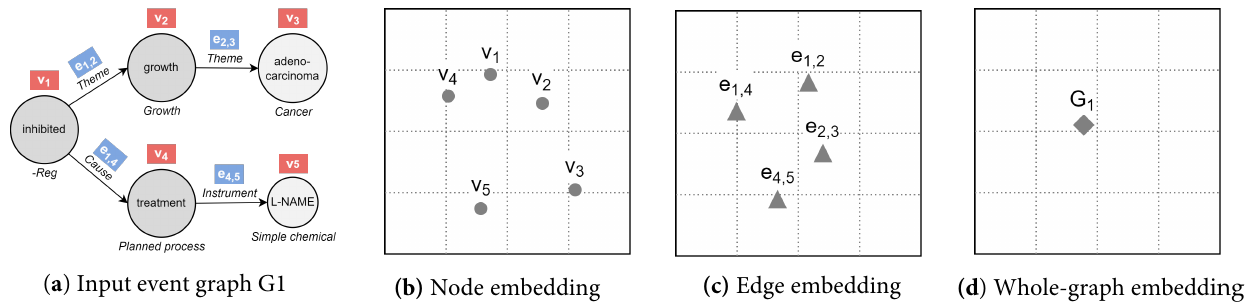
Figure 3. Example of embedding an event graph (a) into a 2D space with different output granularities: node-level (b), Figure 4. Example of embedding an event graph ( a ) into a 2D space with different output granulari- edge-level (c), and graph-level (d). We achieve (d) based on inter-graph node similarities. Knowledge graph embedding ties: node-level ( b ), edge-level ( c ), and graph-level ( d ). We achieve ( d ) based on inter-graph node similarities. Knowledge graph embedding typically mixes nodes and edges in the same space, i.e., a typically mixes nodes and edges in the same space, i.e., a combination of (b) and (c). For visual clarity, node and edge combination of ( b , c ). For visual clarity, node and edge identifiers are shown within red and blue identifiers are shown within red and blue boxes, respectively. boxes,